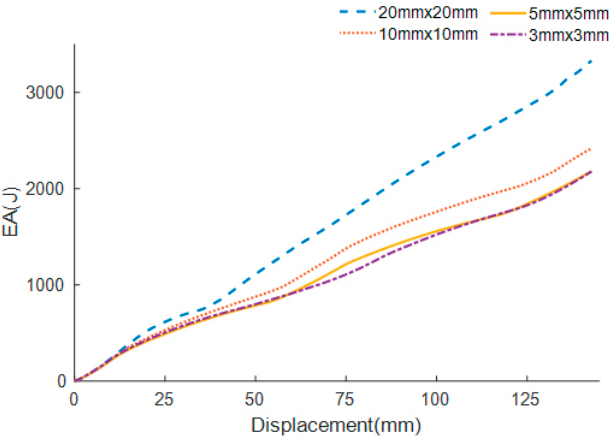
Figure 5. The SEA convergence behaviors of the 0th-order FTTC with various element sizes.